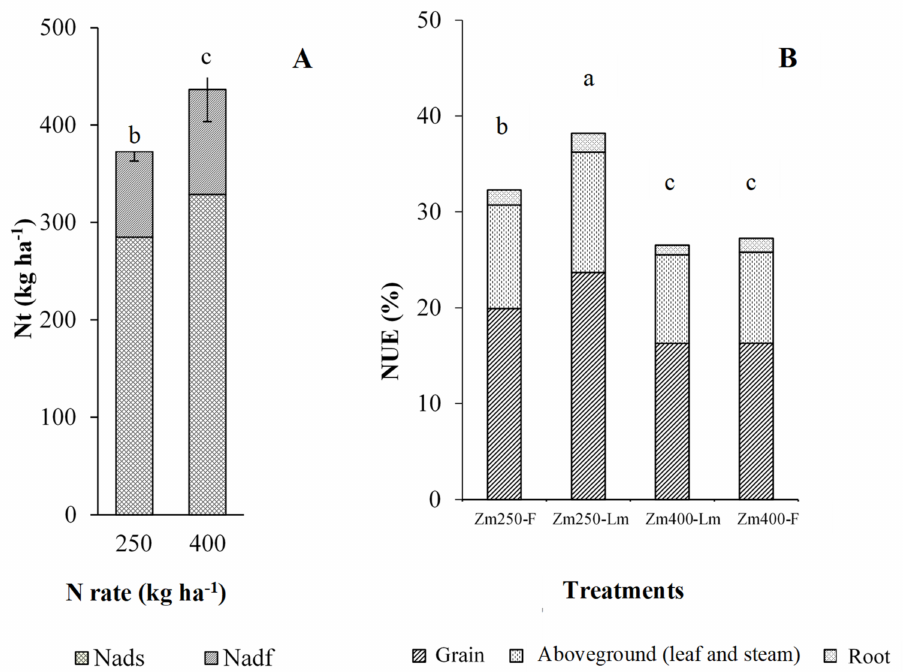
Figure 2. ( A ) Total N uptake from fertilizer and soil. ( B ) Total accumulated nitrogen fertilizer efficiency (NFE) of all fractions of the maize crop. Different letters in the bars indicate statistically significant differences between the treatments based on multiple LSD Fisher comparisons ( α ≤ 0.05), including standard deviation error bars.